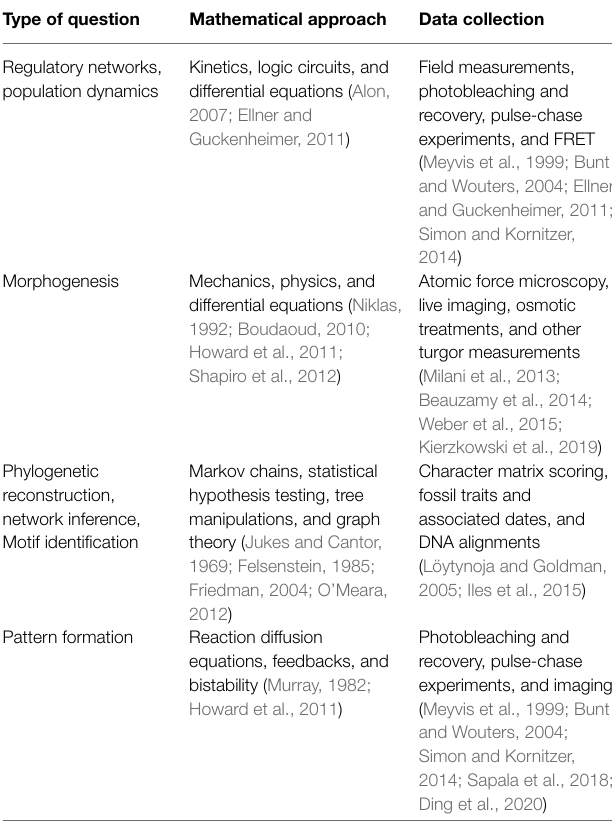
TABLE 1 | Examples of biological questions to model and typical approaches for mathematic representation and data collection. Other probabilistic approaches can be added to account for